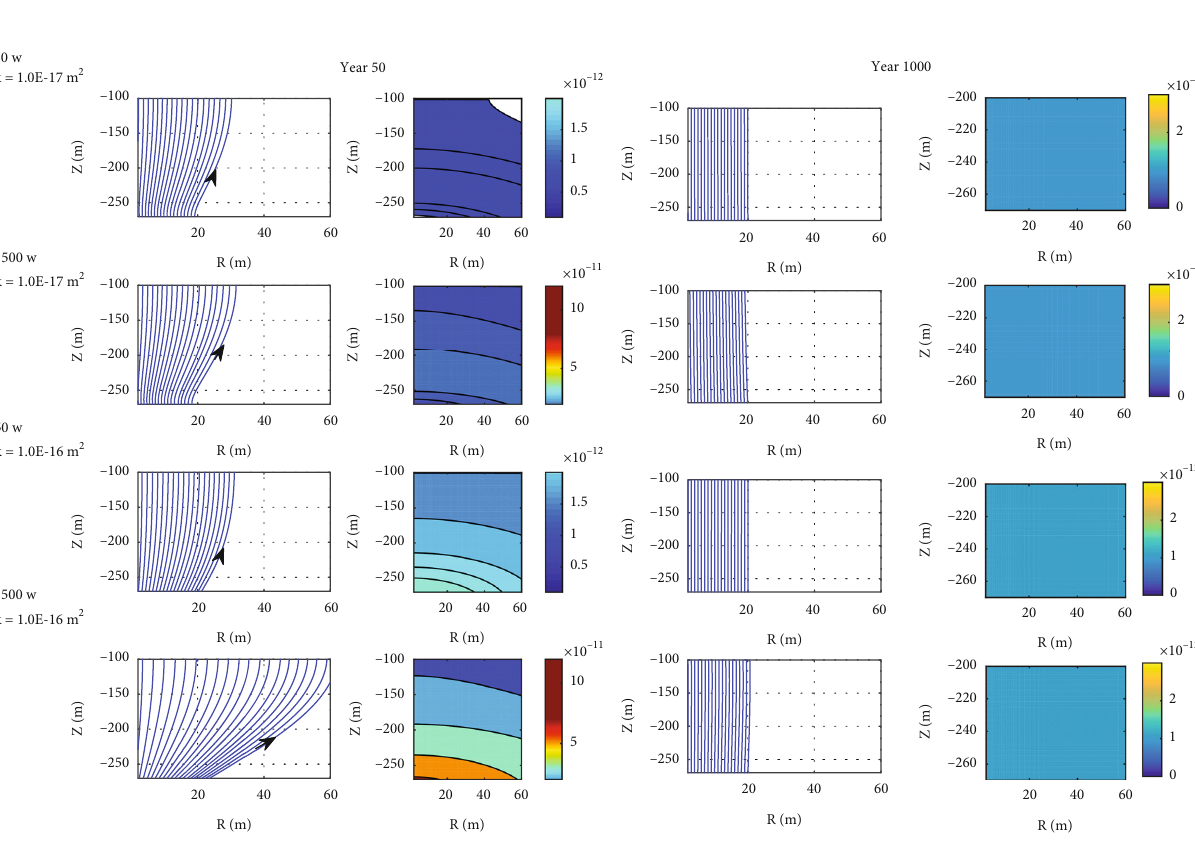
Figure 7: Convection-driven streamlines at 50 ( fi rst column) and 1000 years (third column) and velocity magnitude (m/s) at 50 (second column) and 1000 years (last column). Horizontal line at Z = − 250 is used to display concentration curves in Figure